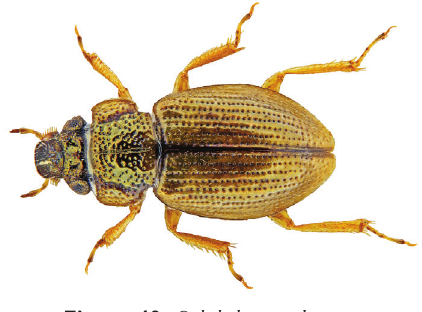
Figure 40. Ochthebius